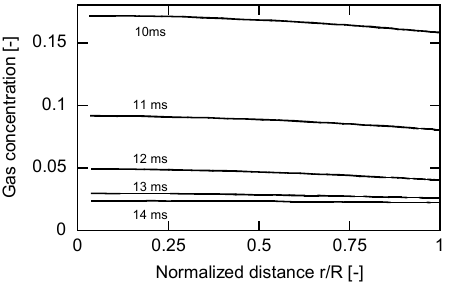
Fig. 8 Instantaneous spatial distributions of gas concentration in the bubble for Fig.